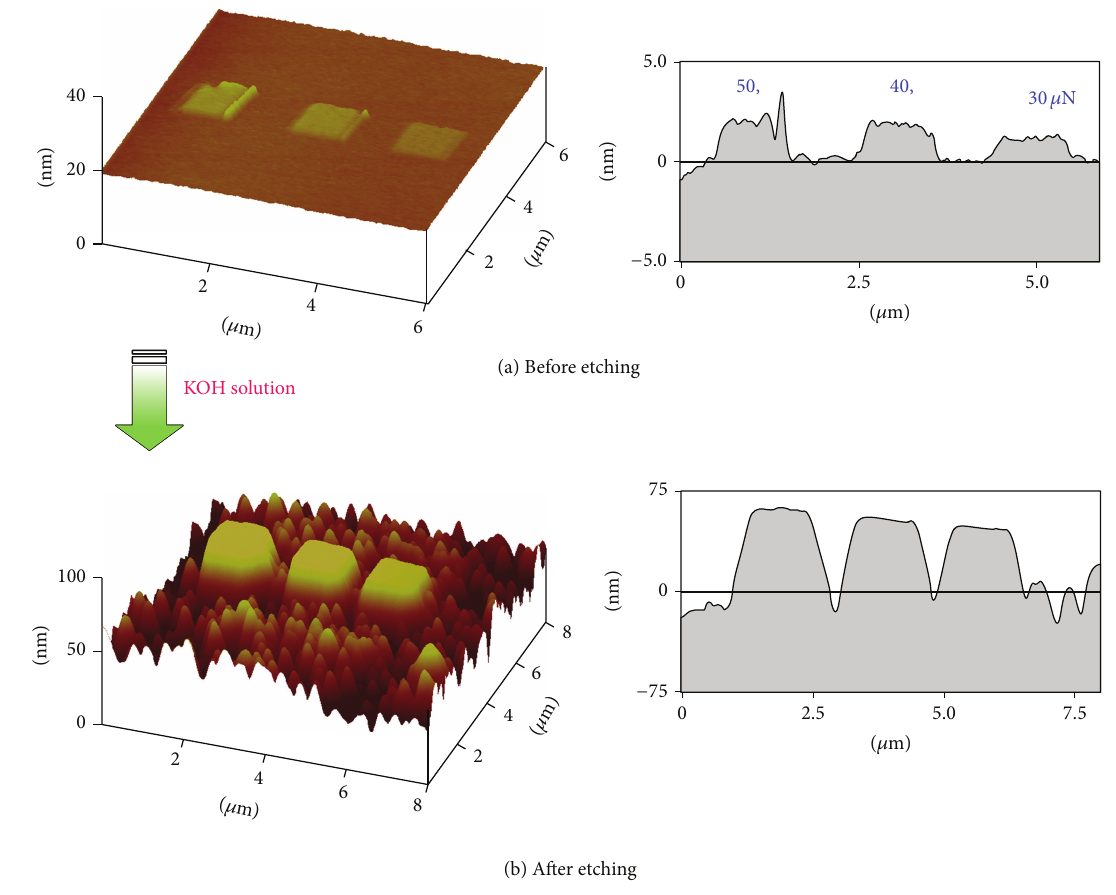
Figure 13: AFM profiles of three square areas processed at different loads (a) before and (b) after KOH solution etching.